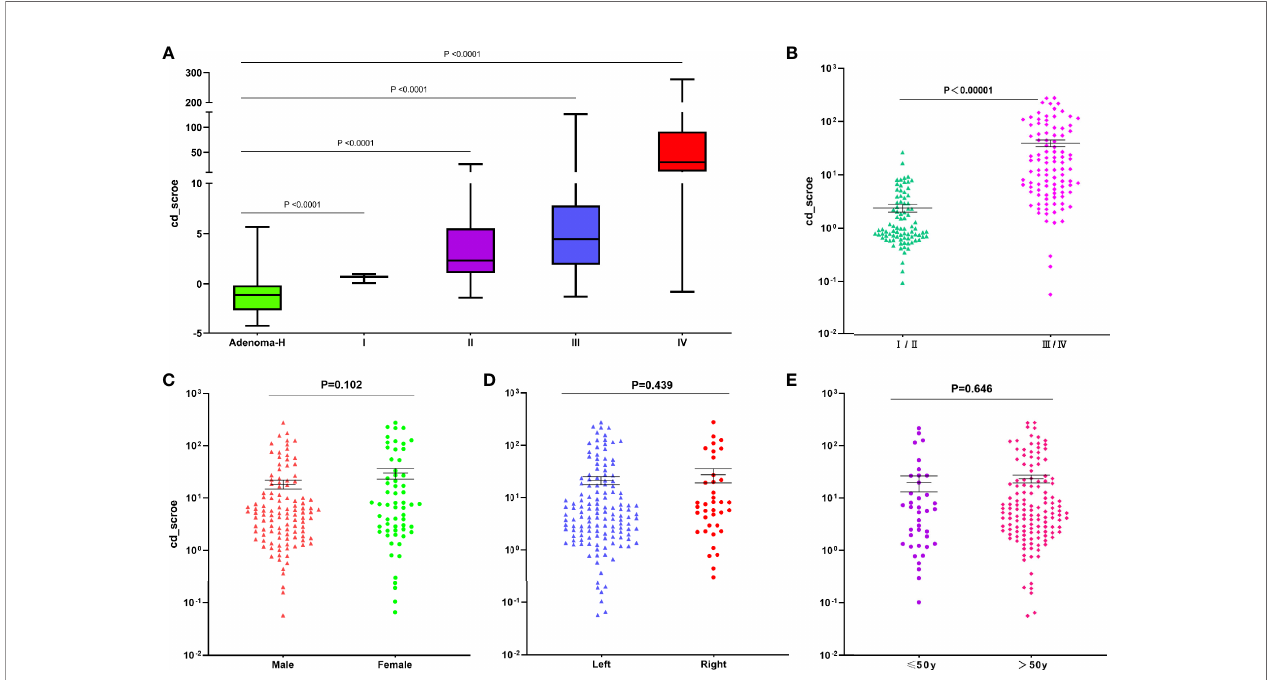
FIGURE 6 | Application of the cd-score of the SDMBP model for predicting tumor stage and different clinical parameters in CRC patients. Cd-score and sensitivity of the SDMBP model in CRC patients with different disease stages (I, II, III and IV) (A, B) ; Cd-score and sensitivity of the SDMBP model in male patients and female patients (C) ; in patients with a primary tumor location on the left or right colon (D) ; and in patients less than 50 years old or over 50 years old (E) . Statistical signi fi cance was assessed by unpaired t